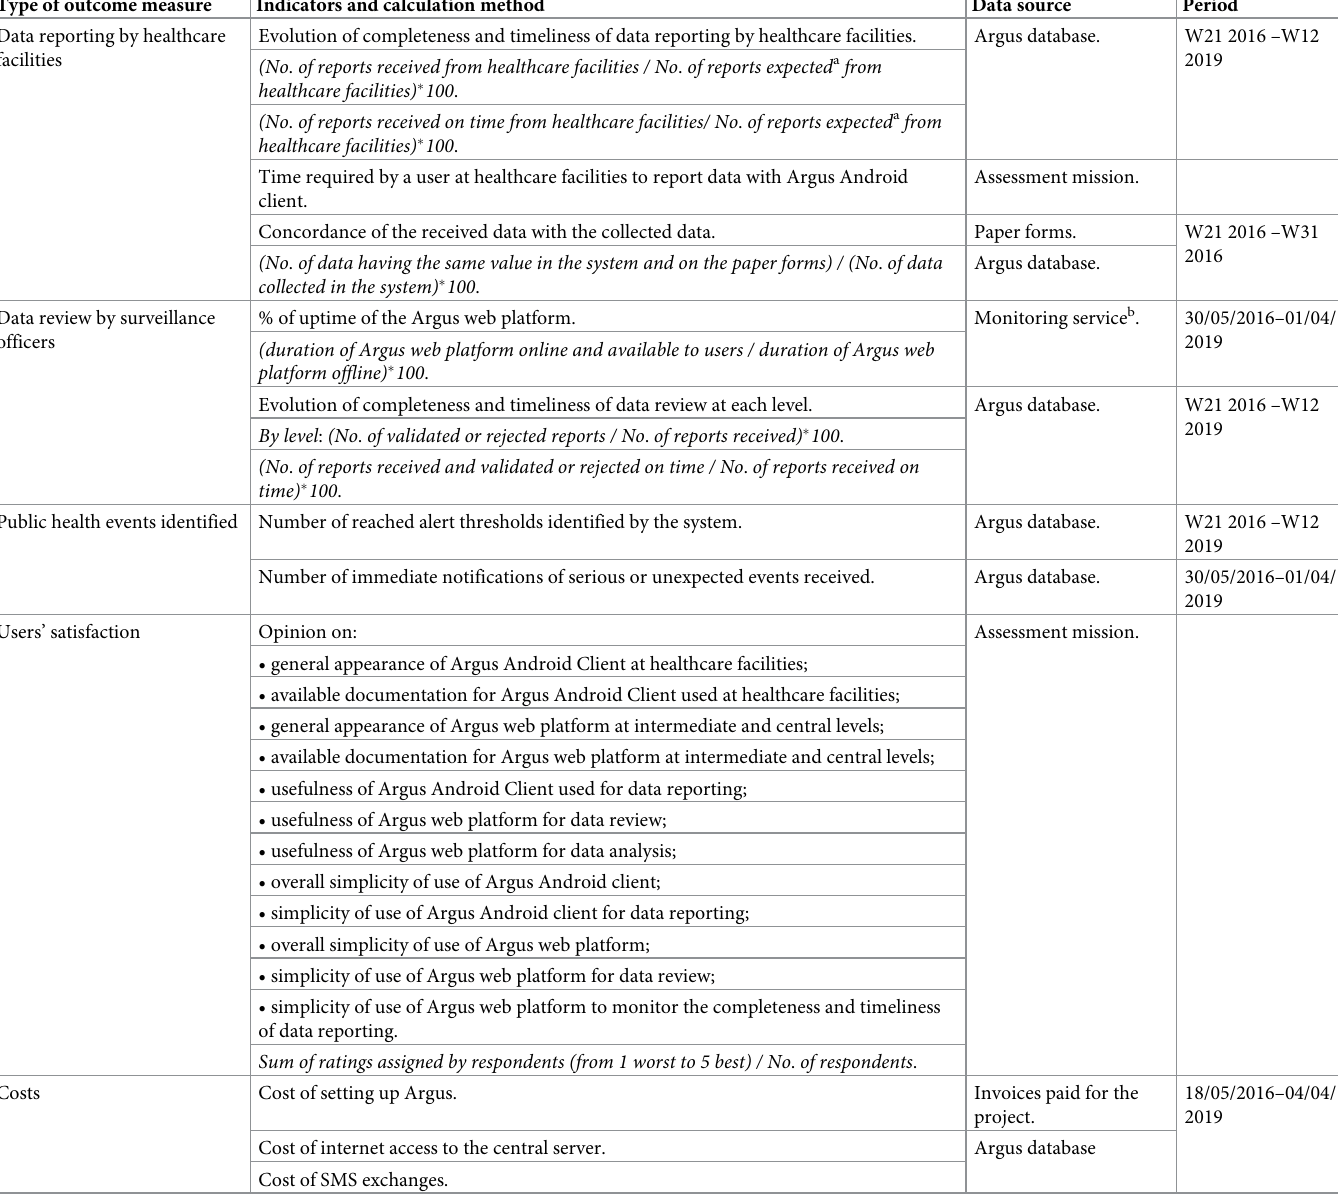
Table 1. Indicators used to describe the Argus pilot test